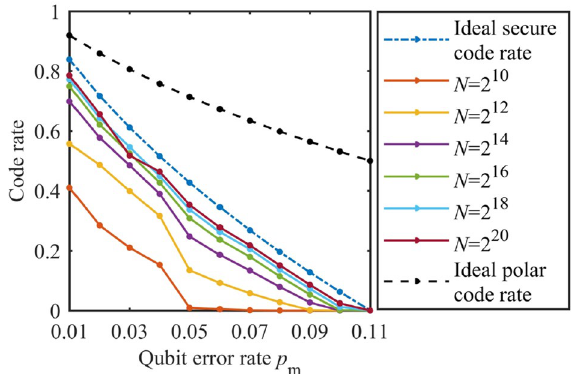
Figure 5. Code rate. The ideal polar code rate is the ideal code rate of polar code itself without considering wiretap channel. The ideal secure code rate is the ideal code rate of PCEP algorithm under wiretap channel